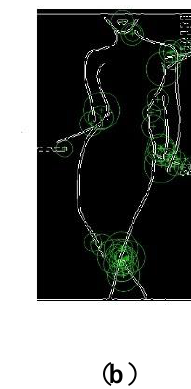
Figure 7. Non-maximal suppression in a neighborhood of 26 points: ( a ) the detected feature point is in the center, and their corresponding scale space model, and ( b ) the input image with the detected feature points .